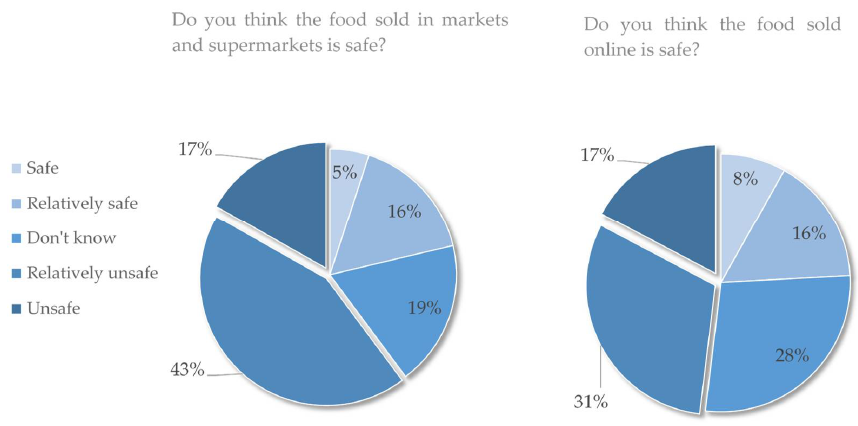
Figure 3. Results of the 799 respondents’ sense of food safety in offline and online sales.